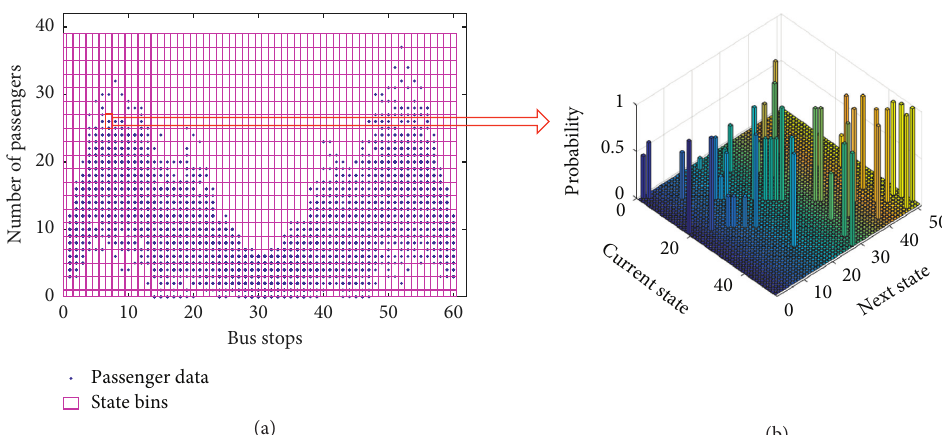
Figure 16: Markov chain model and TPM for off-peak hours. (a) State bins of the driving data and (b) TPM for the 550th state